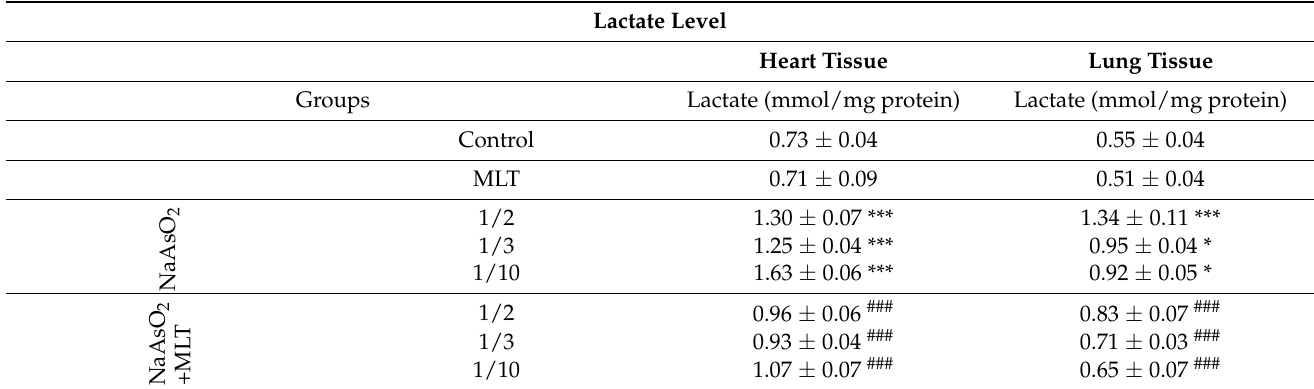
Table 3. Assessment of